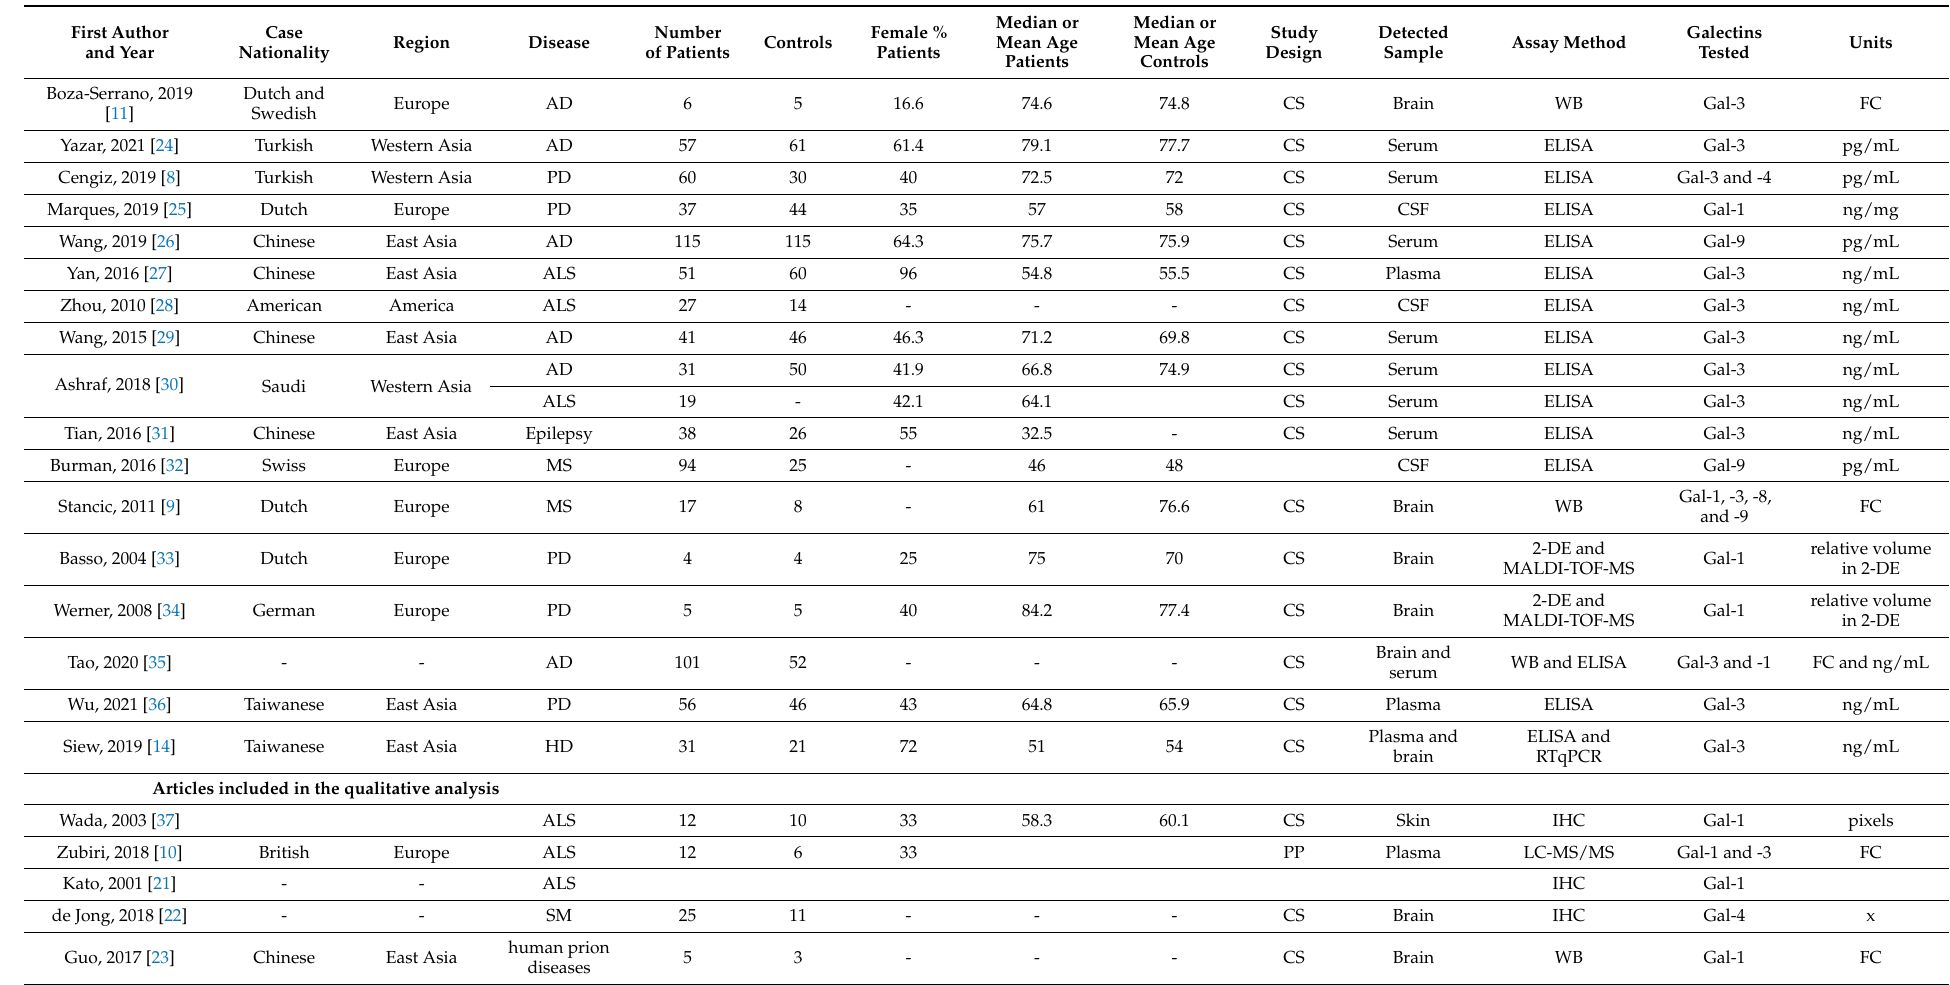
Table 1. Characteristics of the included